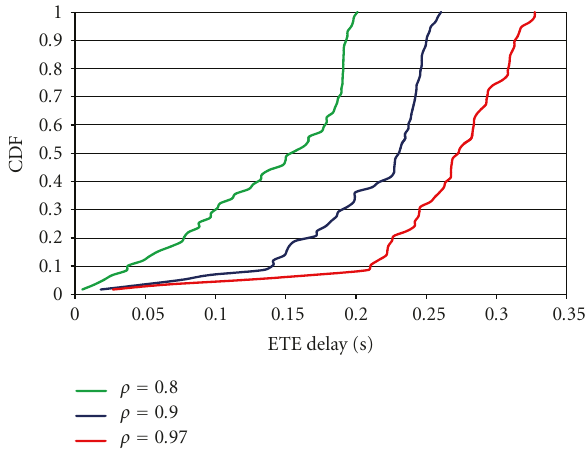
Figure 4: End-To-End delay comparison when using di ff erent directive (low/high)